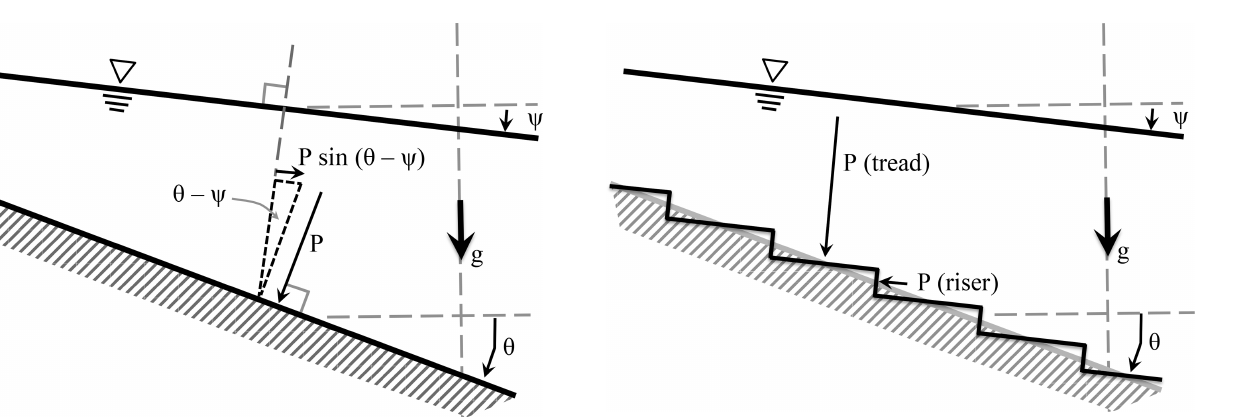
Figure 2. Pressure decomposition to obtain streamwise contribu- tion.